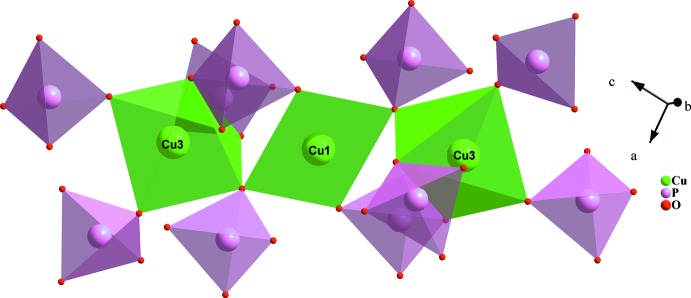
A ribbon, resulting from a Cu3O5–Cu1O4–Cu3O5 trimer connection via vertices of PO4 tetra­hedra.